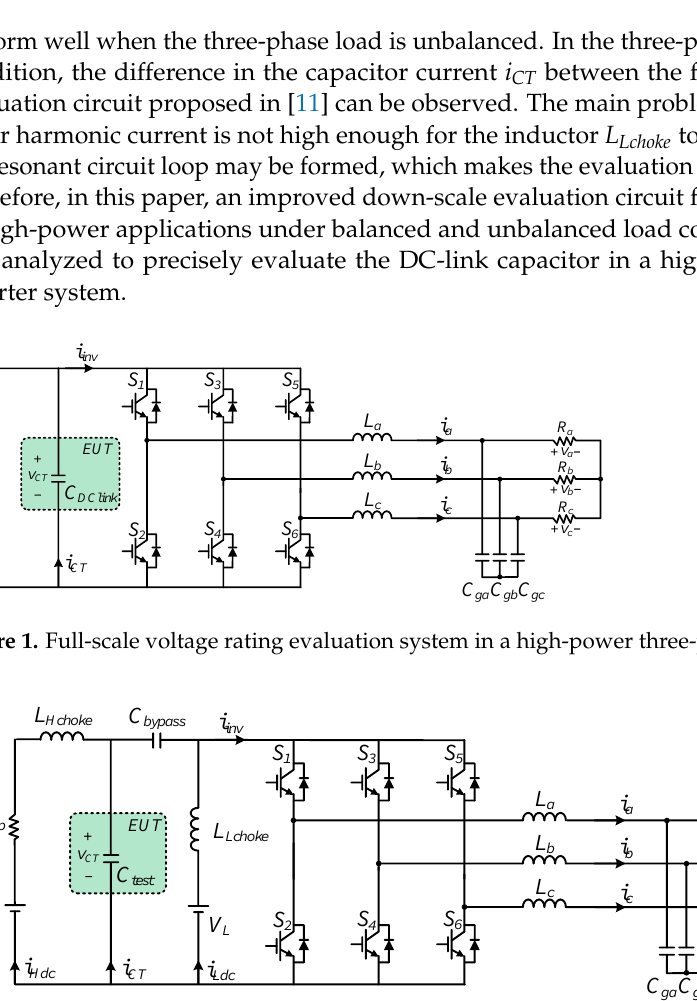
Figure 1. Full-scale voltage rating evaluation system in a high-power three-phase inverter.